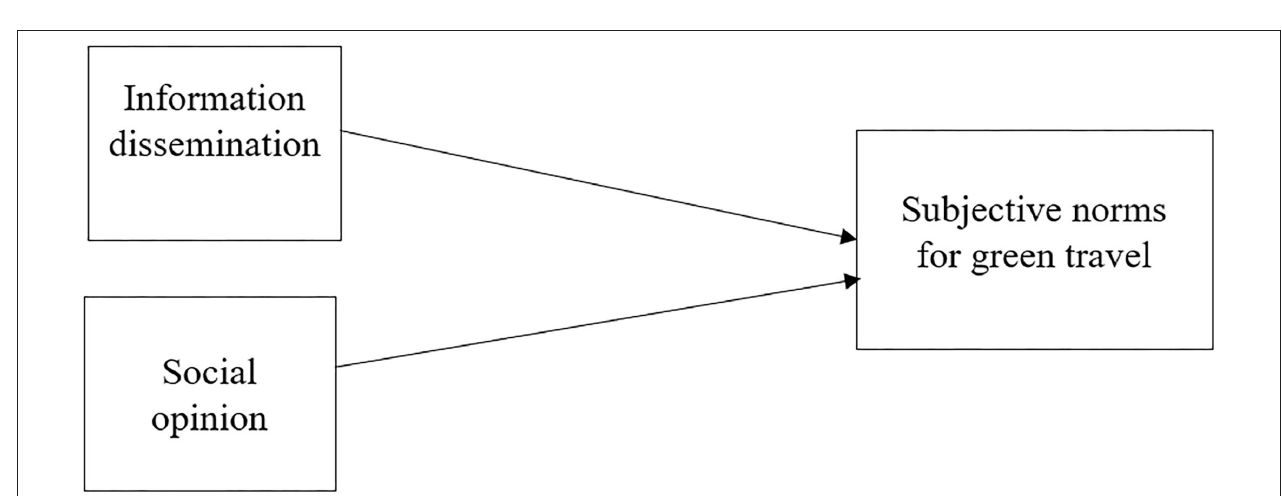
FIGURE 2 | Influence process of social propaganda policies on public subjective norms of green travel.